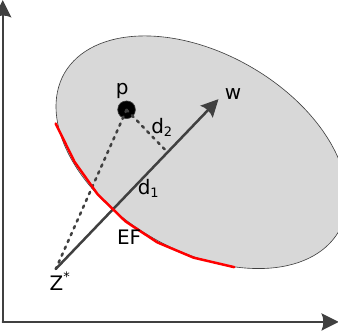
Figure 1. Illustration of PBI method.